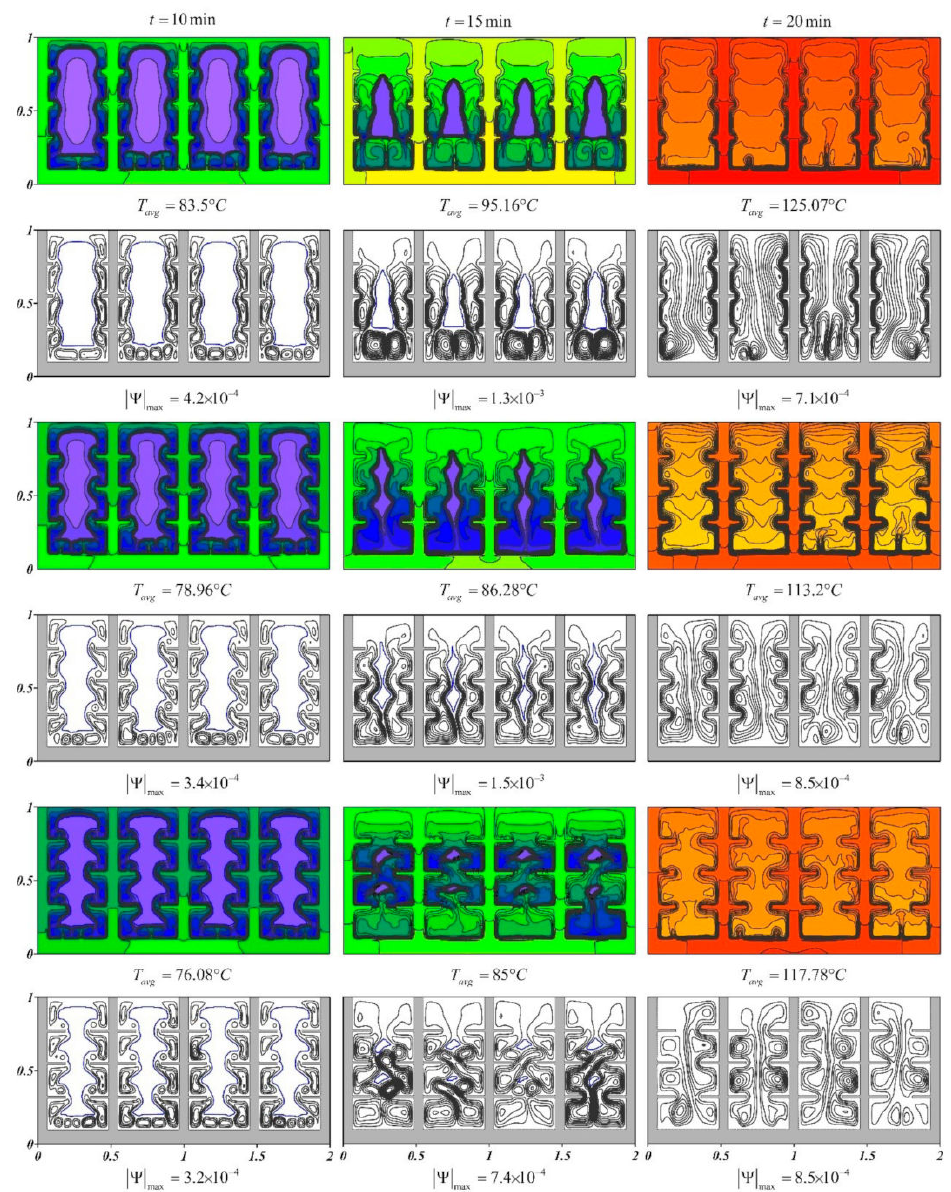
Figure 7. Temperature fields and streamlines at Os = 0.676 for the cases l = H /24, l = H /12, and l = H /8 at the time moments t = 10, t = 15, and t = 20